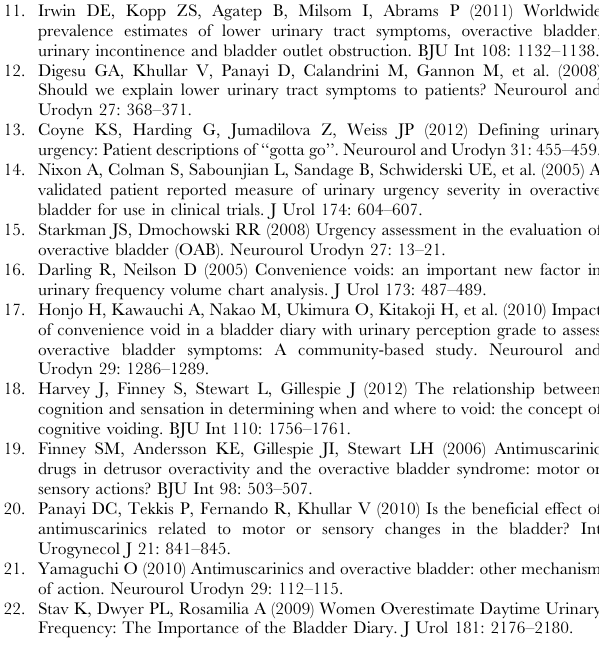
Protocol S1 The original study protocol in Korean. Protocol S2 English translation of the original study